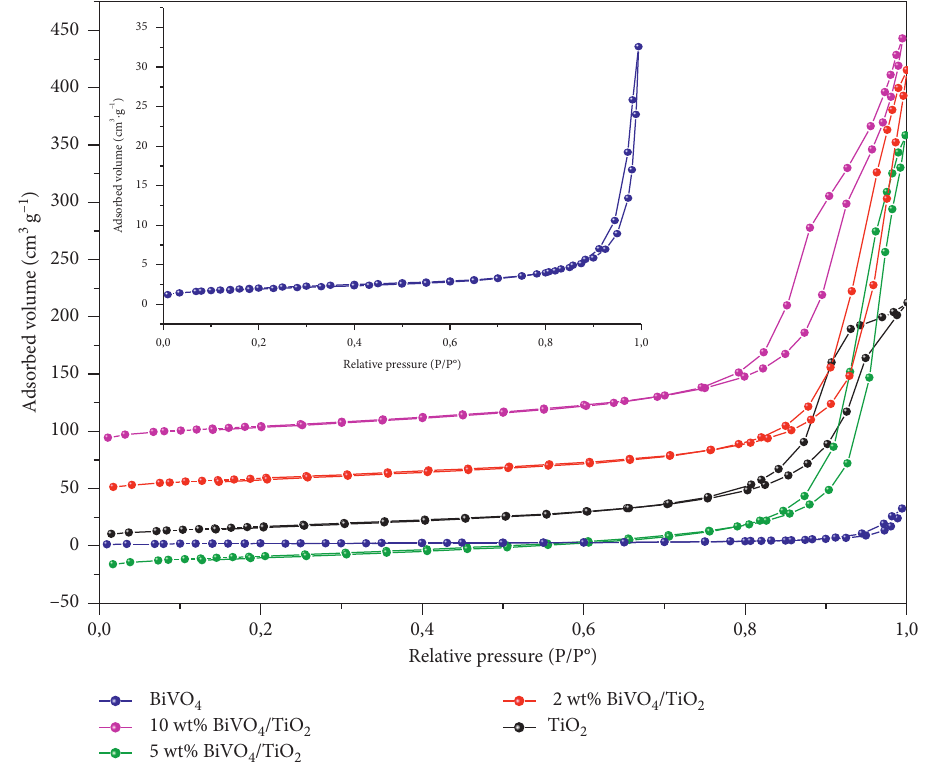
Figure 6: Nitrogen adsorption-desorption isotherm of samples.